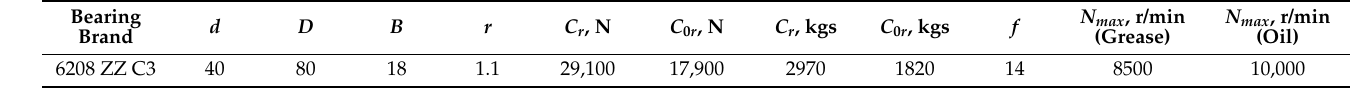
Table 2. Bearing data sheet.